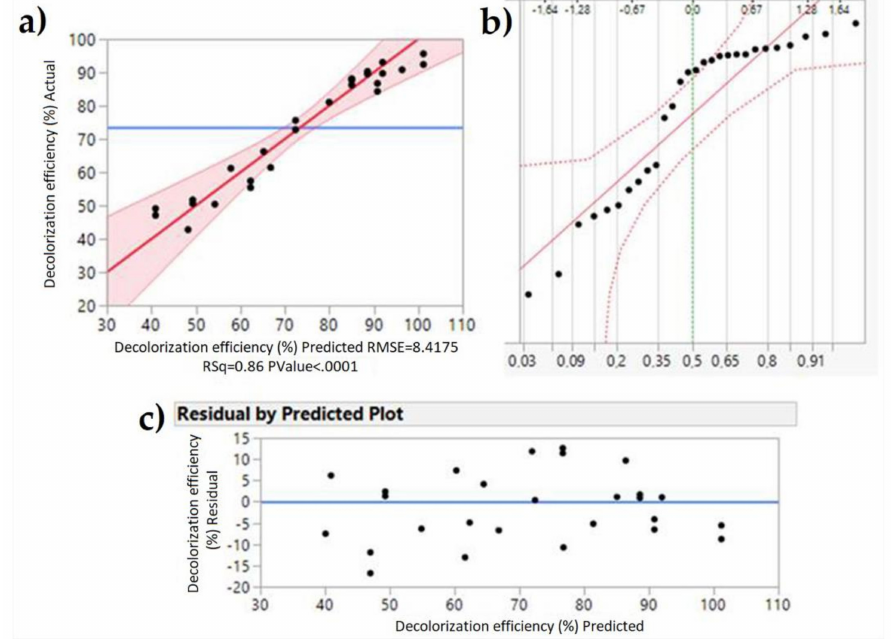
Figure 5. Diagnostic diagrams: ( a ) Diagram of the dependence of the actual in relation to the predicted values of the dye decolourisation efficiency; ( b ) Normal distribution diagram; ( c ) Diagram of the deviation of the standardized residuals from the zero